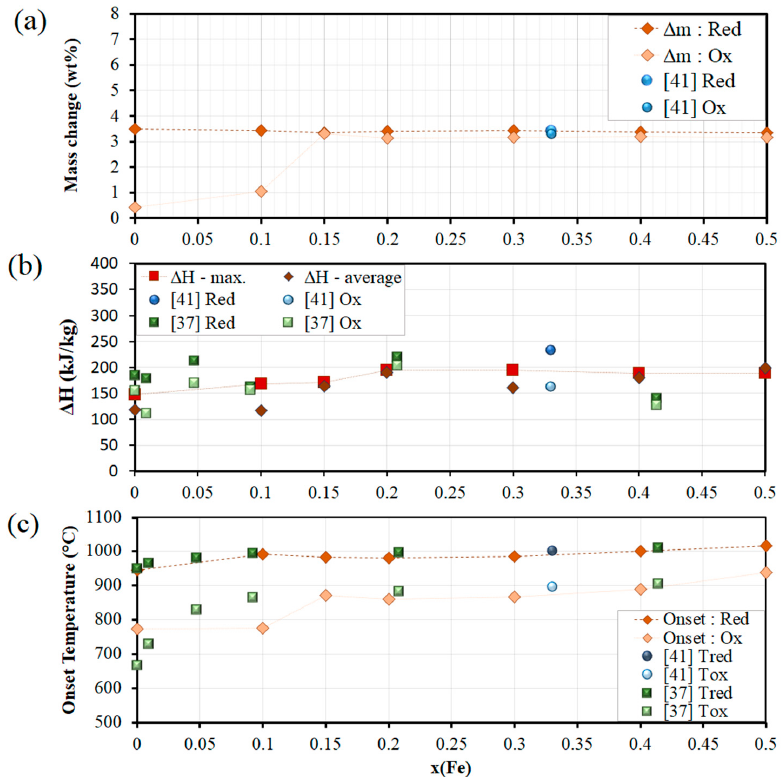
Figure 4. Mass variation (OSC), enthalpy change and onset temperatures of redox reactions measured for the Mn-Fe-O system.